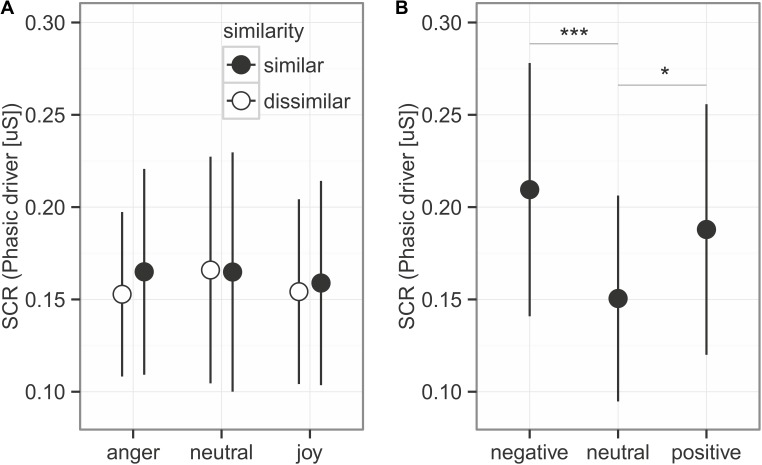
Skin conductance response for the prosodic stimuli (A) and the sounds (B). Given is the mean ± 95% CI phasic driver activity within the response window of 1–6 s after stimulus onset. Asterisks mark the significance levels of the post hoc tests ∗p < 0.05, ∗∗p < 0.01, ∗∗∗p < 0.001.